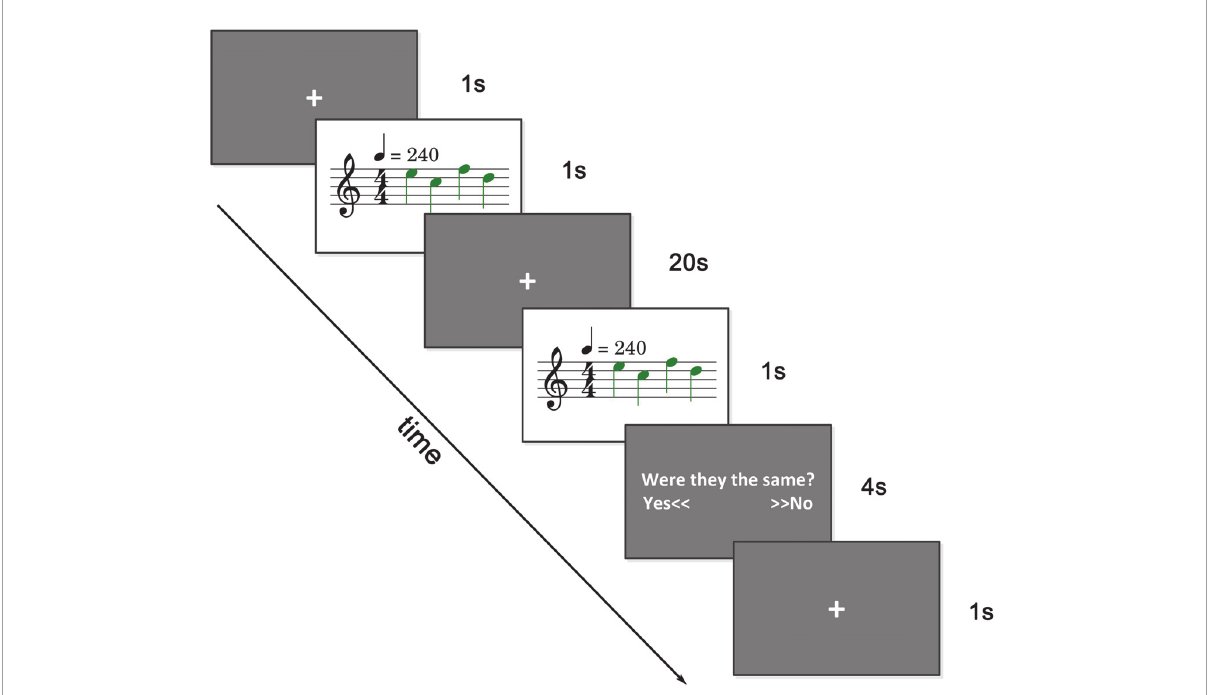
FIGURE1 Experimental paradigm. A series of tones (1–4 tones) were presented and after 20 s, another series of tones (same in length) were presented. There was a 50 percent chance that there was a tone change. Subjects were asked to answer whether these two series of tones were the same within 4